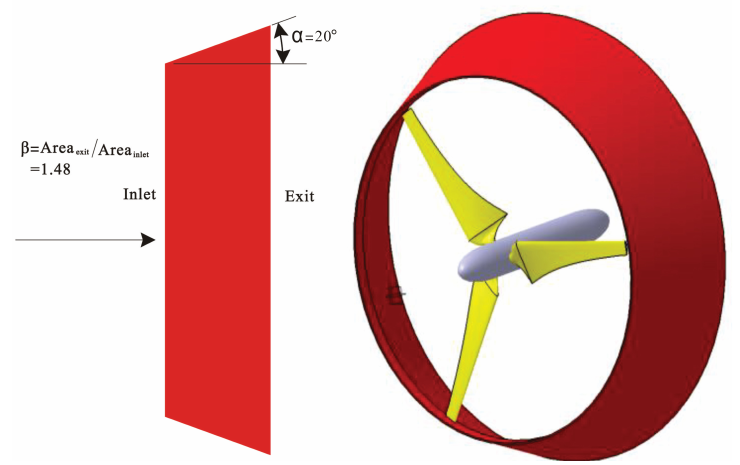
Figure 2. Geometry for the airfoil cross-sectioned